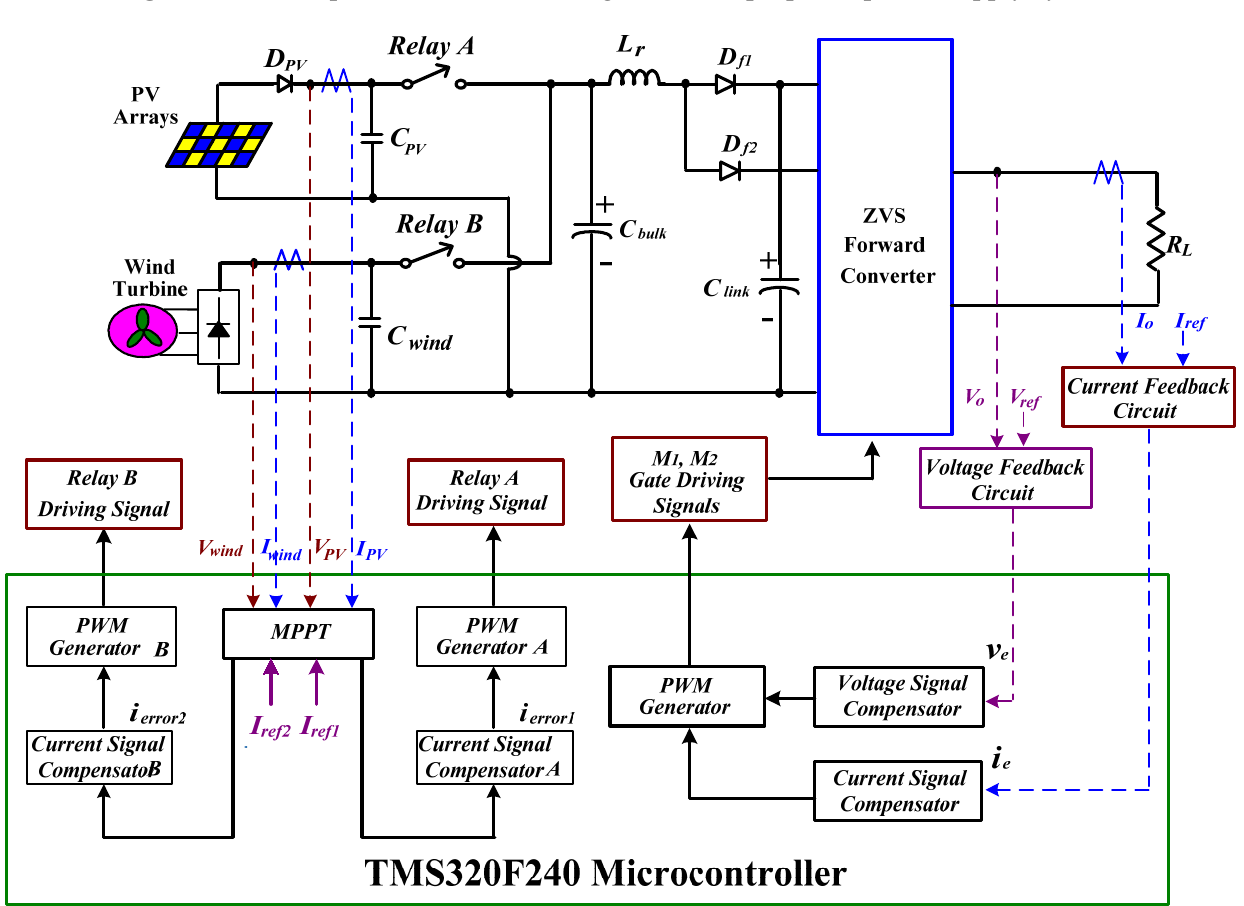
Figure 13. Conceptual control block diagram of the proposed power supply